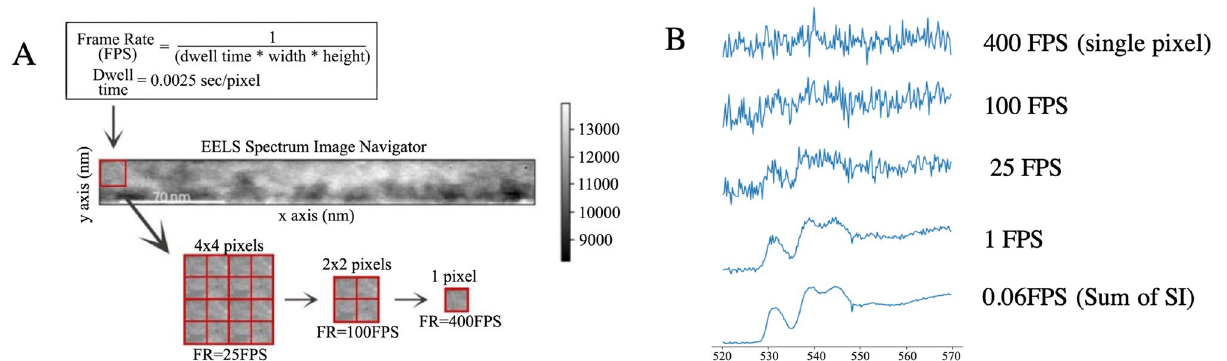
Figure 3. Illustration of the relationship between the ( A ) region of interest (ROI) and frame rate, and the ( B ) impact on the signal to noise ratio when summing all spectra within the ROI. At high frame rates, the low signal to noise ratio makes it impossible to visually analyze or assign structure, as the signal is mostly